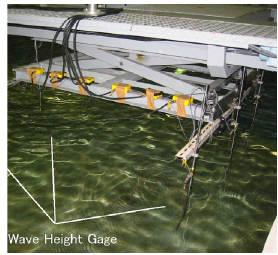
Fig. 5 Photograph of Wave